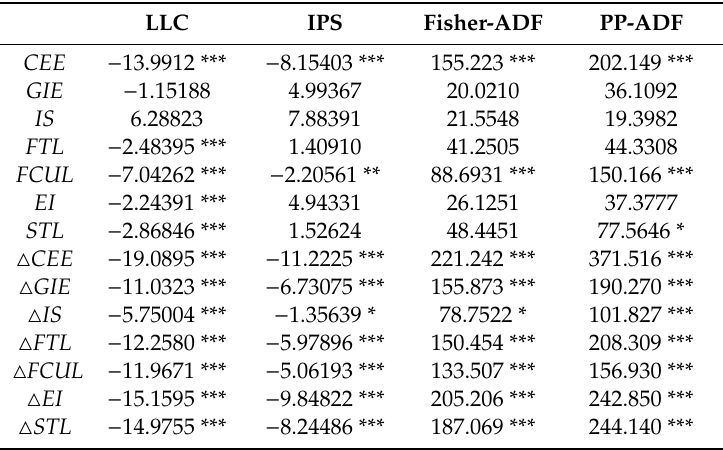
Table 6. Panel unit root test